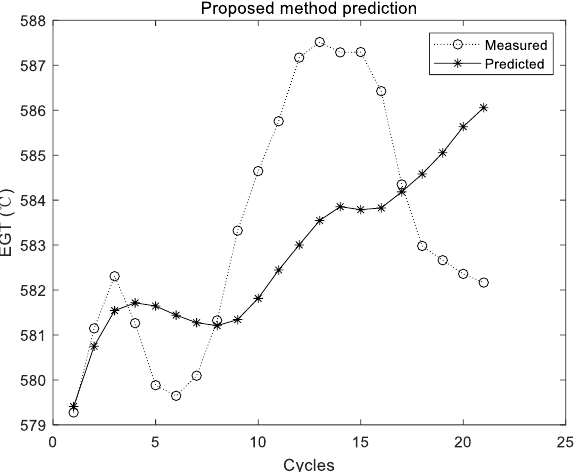
Figure 13. Experimental results of the proposed method using the third group of data.